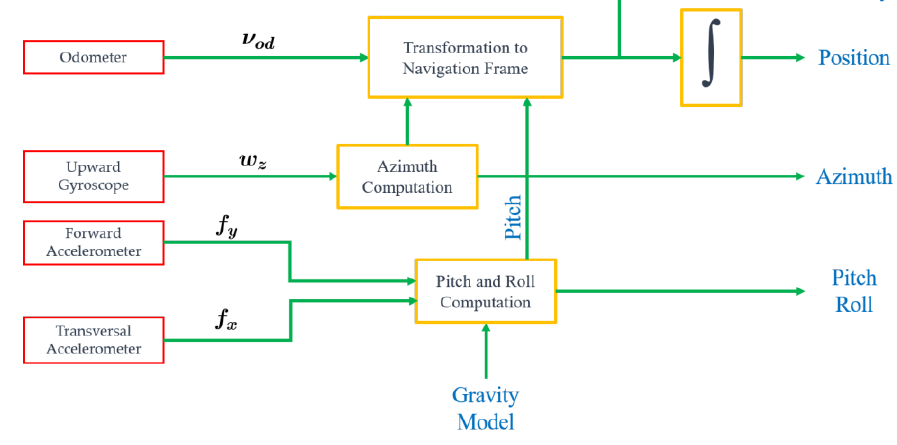
Figure 1. 3D-RISS Mechanization Block Diagram.